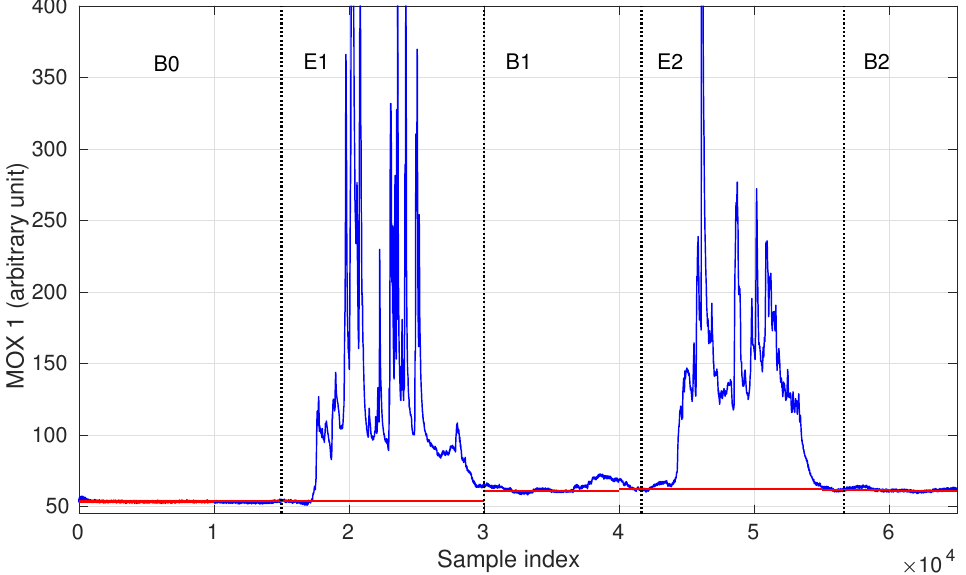
Figure 3. An example of baseline drift of a MOX sensor and adjusted baseline offsets (the red segments after period